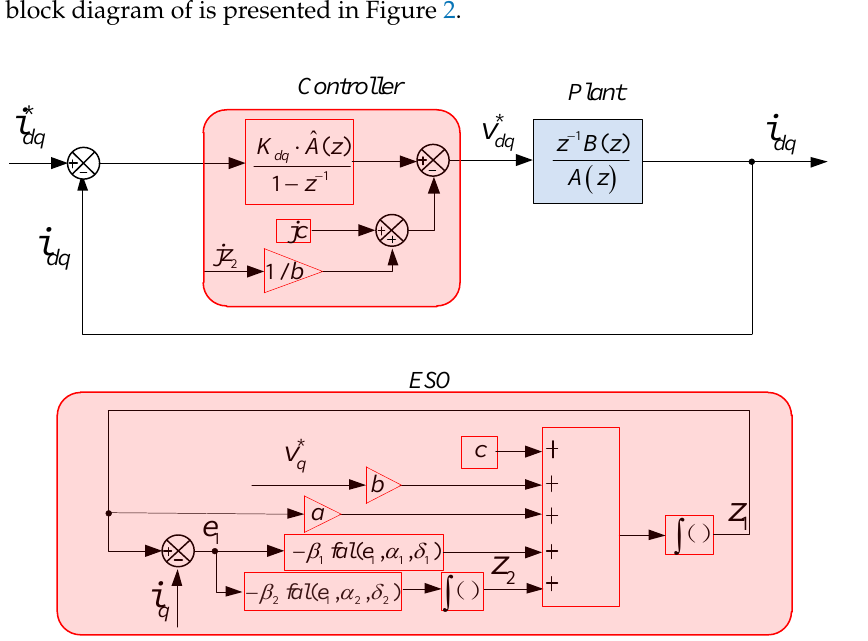
Figure 2. Block diagram of the discrete current controller with zero-pole pair cancellation and ESO-based back-EMF compensation.